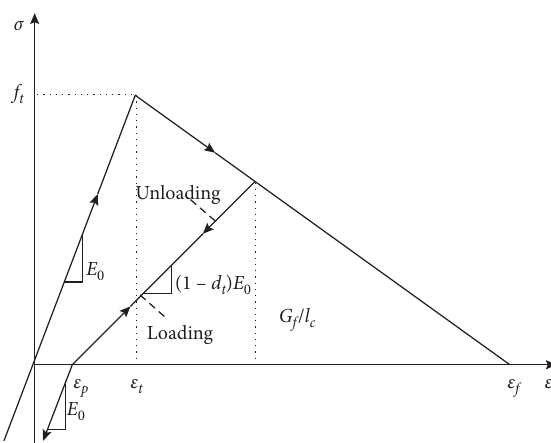
Figure 4: Concrete plastic-damage constitutive behaviour.